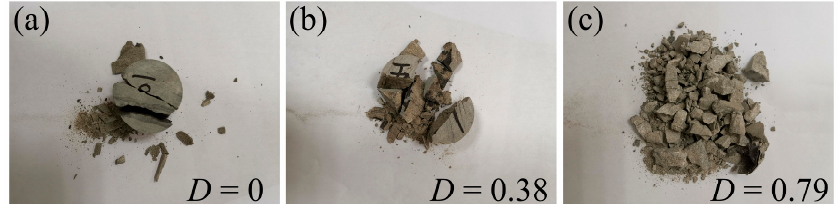
Figure 22. Fragment establishment of sandstone specimens with different accumulated damages: ( a ) D = 0, ( b ) D = 0.38, and ( c ) D = 0.79.